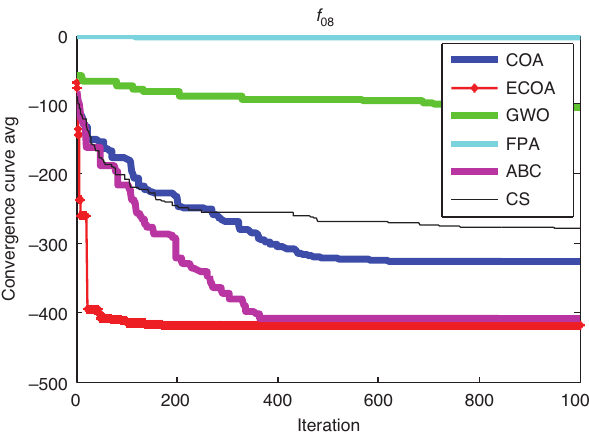
Figure 15: D = 30, Evolution Curves of Fitness Value for f